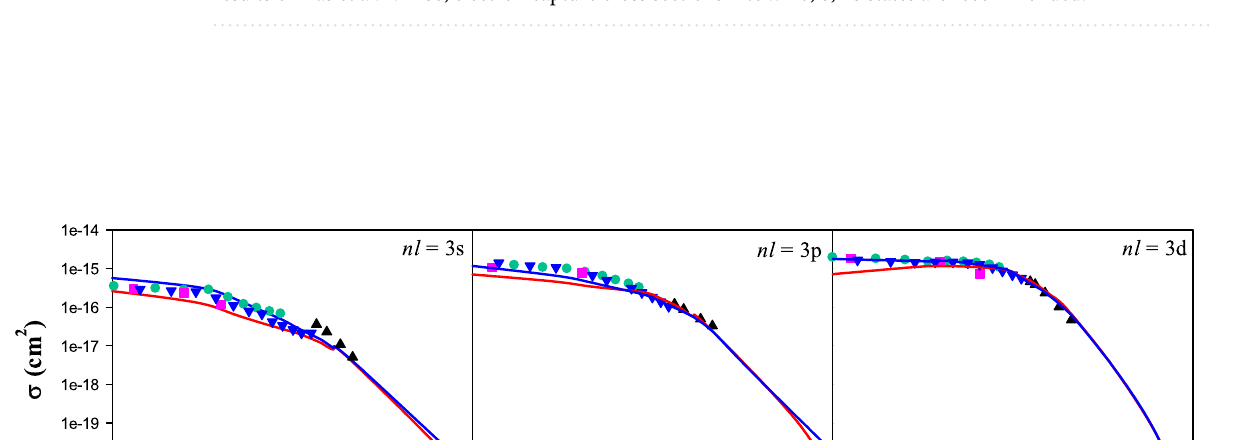
Figure 3. Electron capture cross sections into the n = 3, 4, 5 states of the projectile in Be 4+ + H(1 s ) collision as a function of the impact energy. Solid red line: present CTMC results, solid blue line: present QCTMC results, pink squares: AOCC results of Fritsch 5 , green circles: QMOCC results of Harel et al. 4 , black triangles: BCCIS results of Das et al. 14 . Also, electron capture cross sections into n = 6, 8, 10 states are recommended.